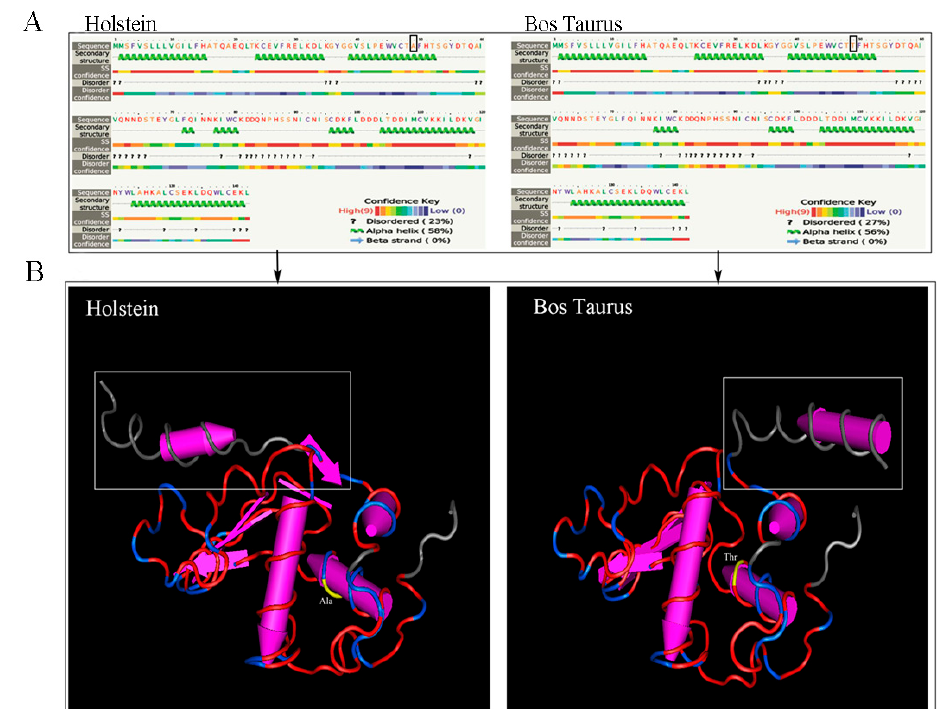
Figure 4. Bovine α -LA spatial structure (secondary and tertiary structure) analysis and alignment between Holstein and Bos Taurus. ( A ) Secondary structure of bovine α -LA between Holstein (left) and Bos Taurus (right) were changed, including α -helices and β corners; ( B ) Tertiary spatial structure of the α -LA changes significantly (box mark) between Holstein (left) and Bos Taurus (right).